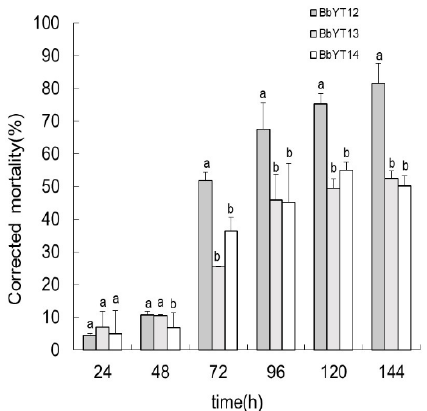
Figure 1. Insect bioassays. Time course of corrected mortality of F. occidentalis infected with B. bassiana . Data were subjected to one-way ANOVA for each isolate at a given time point. Means in each column within each isolate followed by the different letter indicate significant difference at p < 0.05. Error bars = standard deviation.